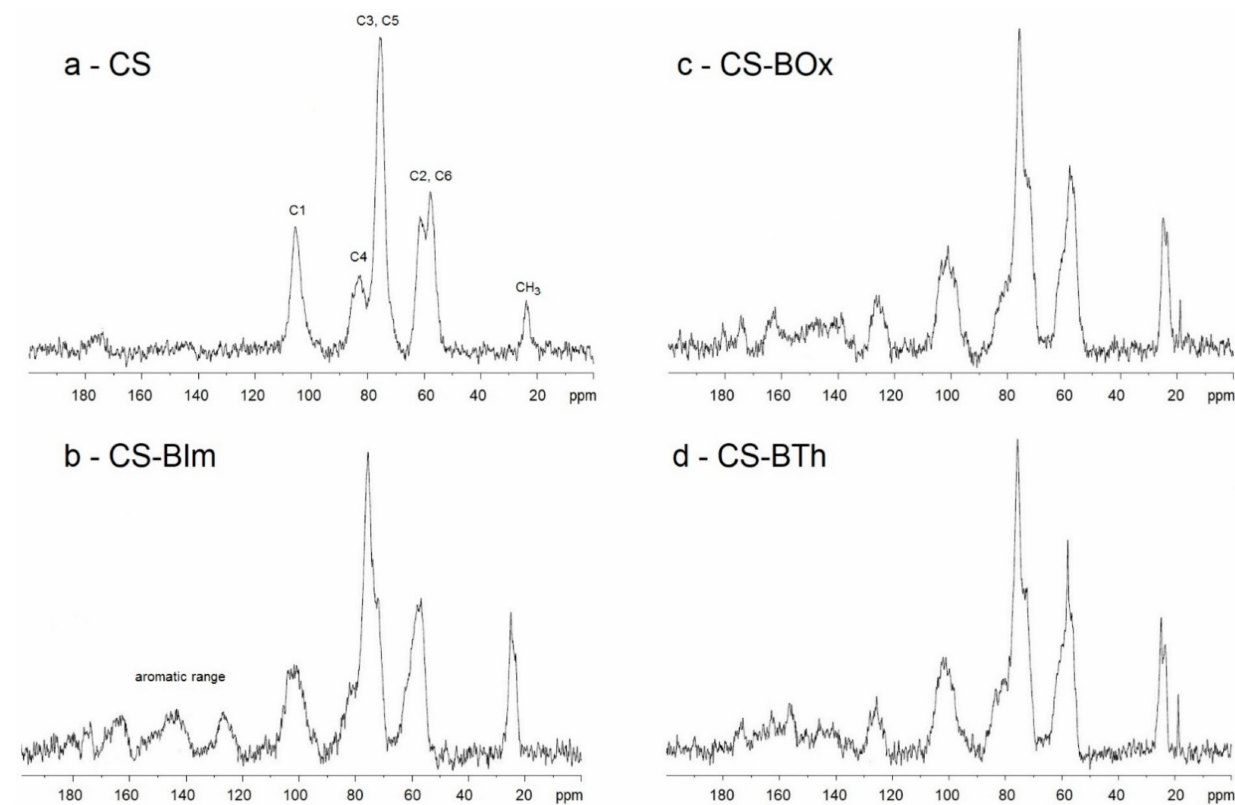
Figure 2. Solid-state 13 C-NMR spectra of CS ( a ), CS-BIm ( b ), CS-BOx ( c ), and CS-BTh ( d ).